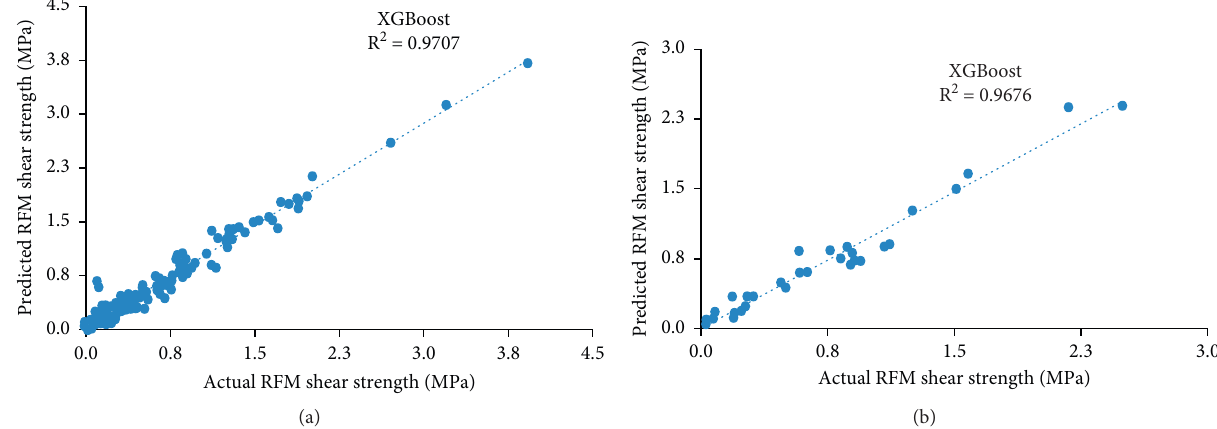
Figure 3: Regression graph of the XGBoost model for (a) training and (b) testing datasets.